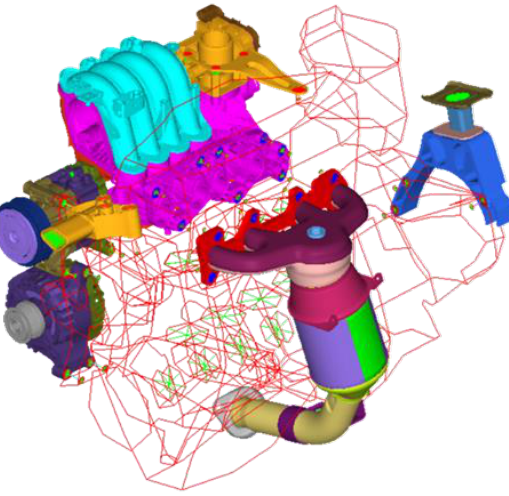
Figure 13. Reduced model of the engine with all sub-components modelled by FEM.